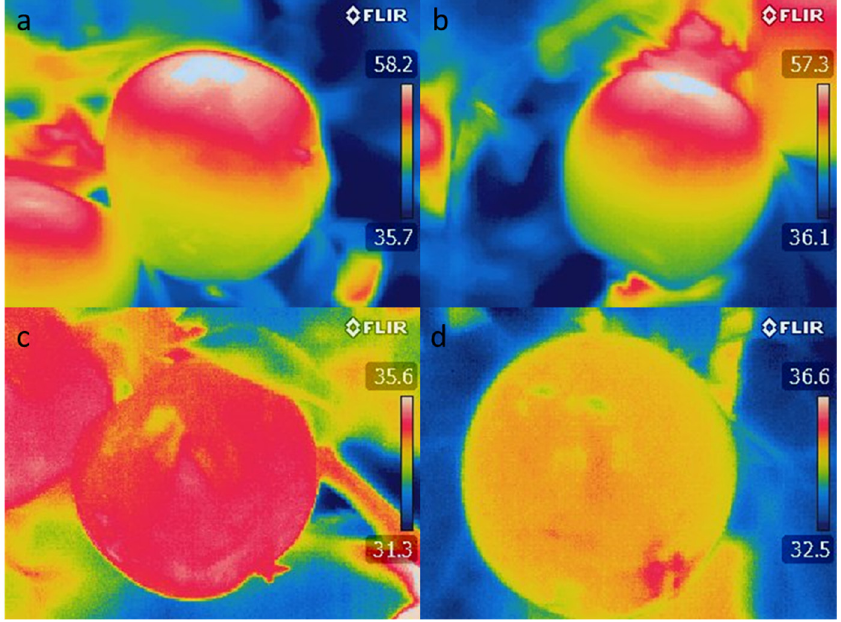
Figure 4. Examples of fruit temperature evaluated with an IR camera (FLIR E50). The scale represents the temperature (°C) in each image. ( a , b ) are fruits in the Control treatment (CON), while ( c , d ) are fruits in BN50 (Black net 50%).